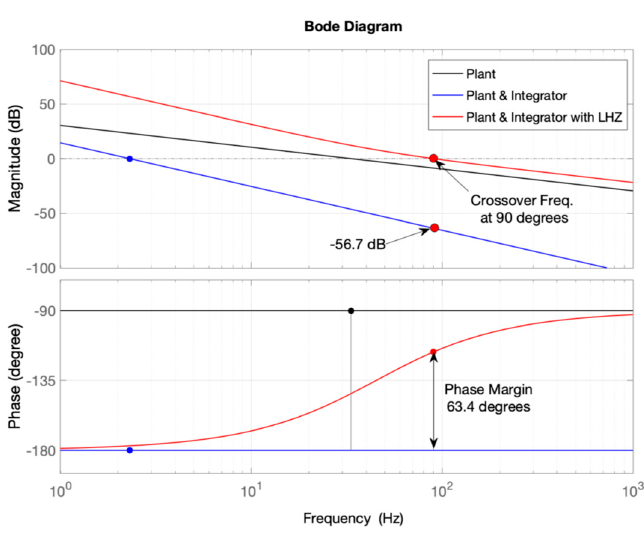
Figure 19. The Bode plots for different steps for the current control loop design.